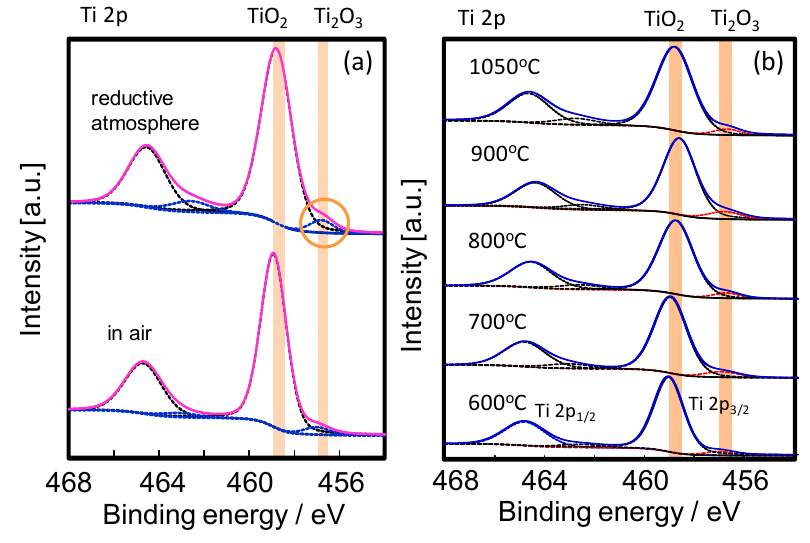
Figure 4. Ti 2p XPS spectra of the catalysts prepared at 800 °C in air and in Ar